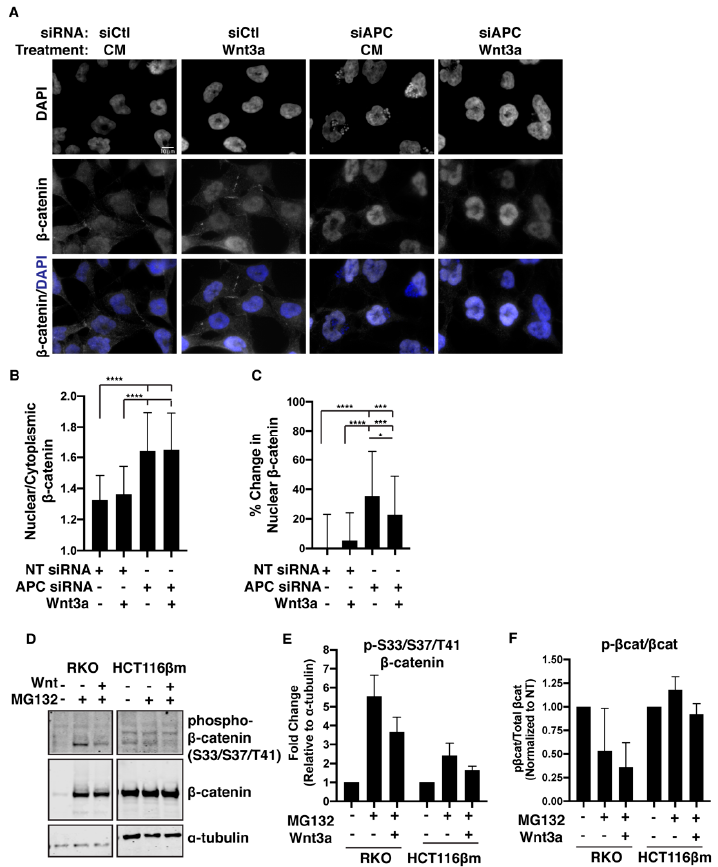
Figure 5. β -cat ∆ S45 nuclear localization is controlled by APC and continues to be susceptible to GSK-3 β phosphorylation and proteasomal degradation. ( A ) HCT116 β m cells transfected with control-siRNA or APC-siRNA were treated with 125 ng Wnt3a and β -catenin localization was visualized by immunofluorescent detection. ( B ) Ratio of nuclear to cytoplasmic β -catenin quantified from immunofluorescent staining. Data representative of at least 36 individual cells per group (from two independent experiments). Error bars, SD; Statistical analysis by t -test: * p < 0.05, *** p < 0.001, **** p < 0.0001. ( C ) Percent change in nuclear β -catenin. Percent of nuclear β -catenin was calculated by dividing nuclear β -catenin by total β -catenin. Using nuclear β -catenin percentage, the percent change was calculated by comparing it to control. ( D ) RKO and HCT116 β m cells were treated with 10mM MG132 in the presence or absence of 25ng/mL Wnt3a for 4 h prior to lysis. Western blot utilizing anti-phospho-Ser33/Ser37/Thr41- β -catenin or anti- β -catenin antibodies. ( E ) Quantification of the fold change of Ser33/Ser37/Thr41-phosphorylated β -catenin. Data averaged from two independent experiments. Error bars, SD. ( F ) Quantification of the ratio of phosphorylated- β -catenin to total β -catenin in RKO and HCT116 β m cells following treatment with MG132 +/ − Wnt3a. Data averaged from two independent experiments. Error bars, SD.